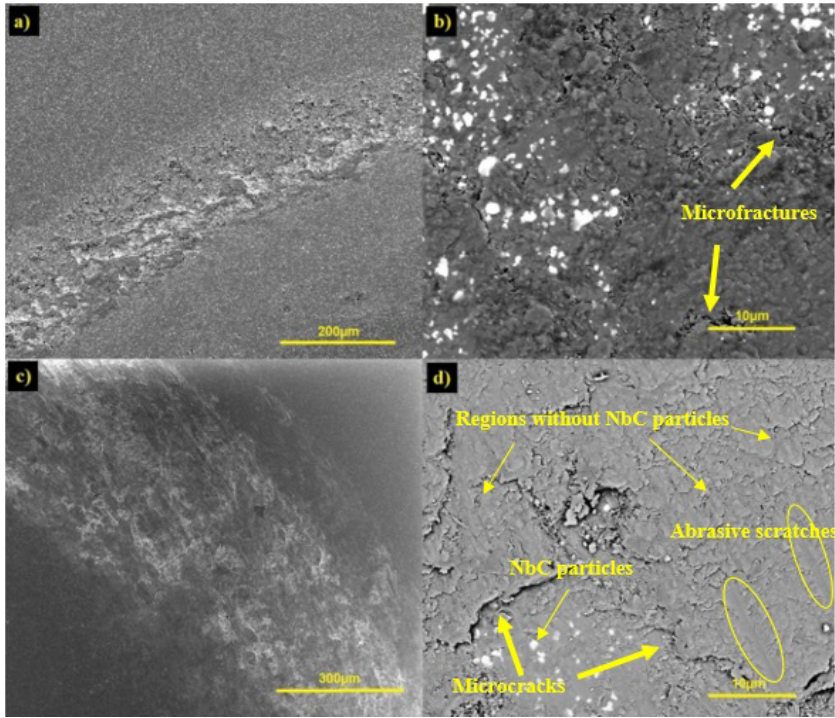
Figure 4. Secondary electrons micrographs of the wear tracks and wear zones of (a,b) A70N30 and (c,d)